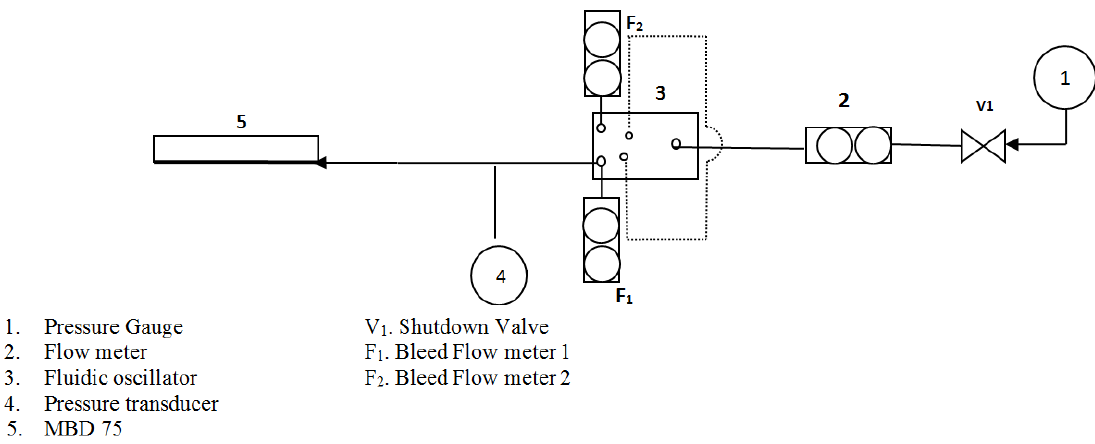
Figure 3. Schematic of the